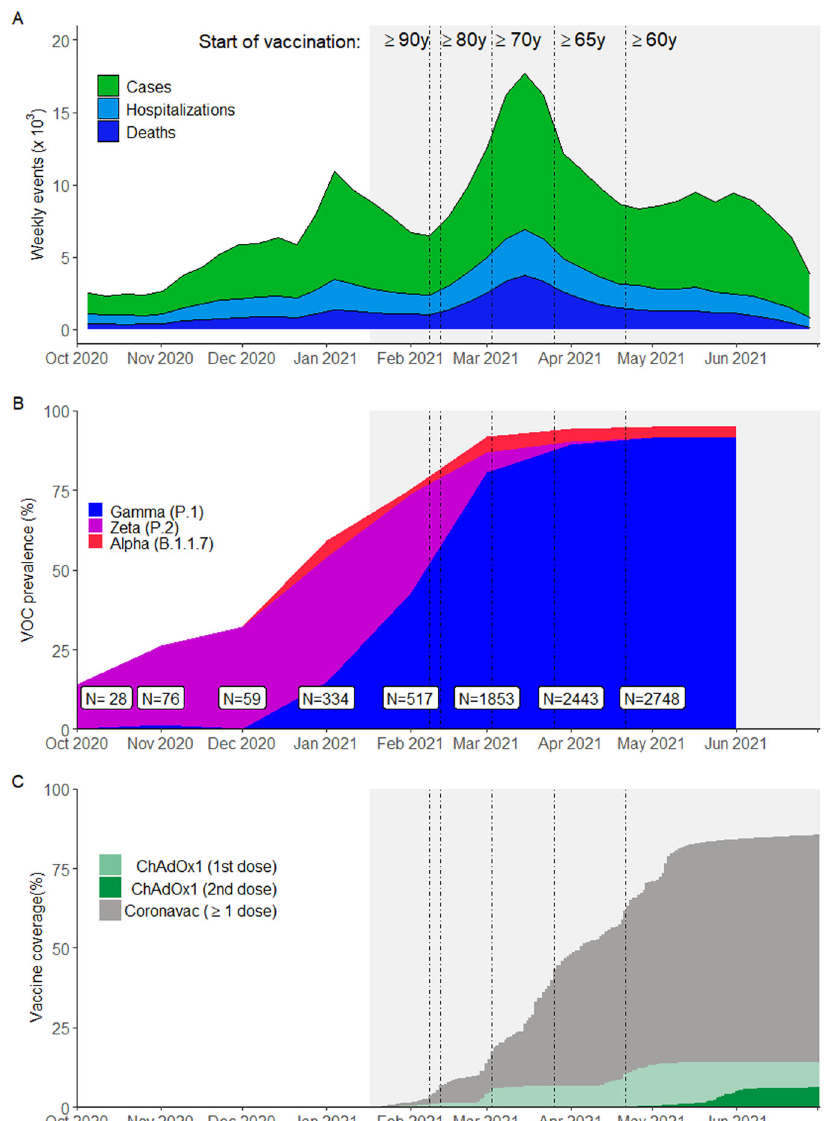
Fig. 1 Incidence of reported Covid-19, vaccination coverage, and prevalence of SARS-CoV-2 variants of concern from Oct 1, 2020 to July 2, 2021 in São Paulo State, Brazil. A The weekly case count of cases, hospitalizations, and deaths based on positive RT-PCR/Antigen tests for the age group ≥ 60 years. B The monthly prevalence of main SARS-CoV-2 variants of concern among genotyped isolates in the GISAID database 11 (extraction on July 7 2021). Prevalence was omitted for June and July due to low sample count. C Daily cumulative vaccination coverage for age group ≥ 60 years. Population estimates were obtained from national projections for 2020 35 . Vertical lines, from left to right in each panel, show the dates that adults ≥ 90, 80 – 89, 70 – 79, 65 – 69, and 60 – 64 years of age in the general population became eligible for vaccination. The gray shaded area represents the study period. Source data are provided as a Source Data fi